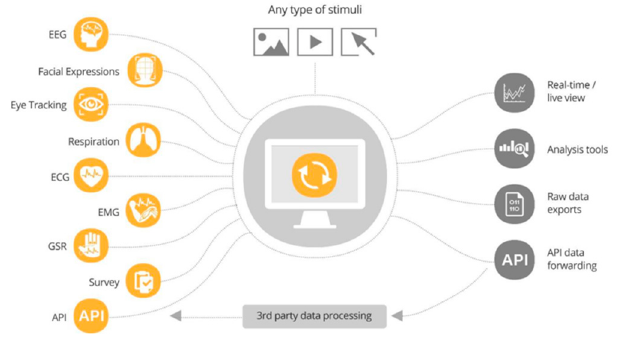
Figure 3. The iMotions platform for analysis of eye movements, GSR, EEG, EMG and ECG together with imported data through an API [Source: